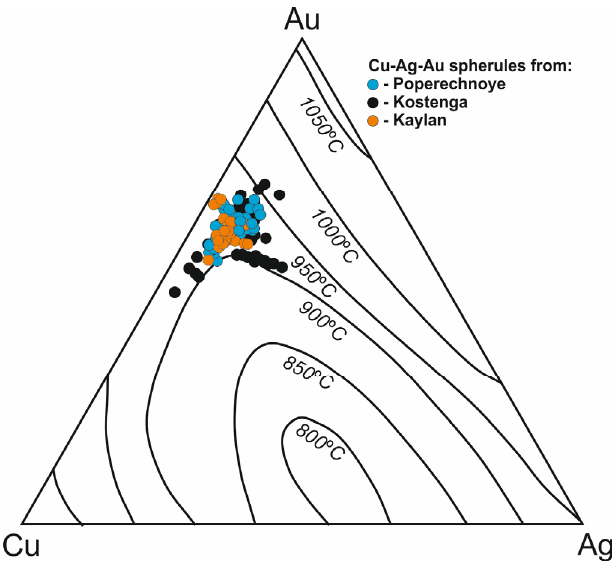
Figure 18. Compositions of Cu-Au-Ag spherules plotted on ternary phase diagram for Au-Cu-Ag modified after [77] with additions from [78,79]. Lines depict liquidus temperatures at different end-member compositions.